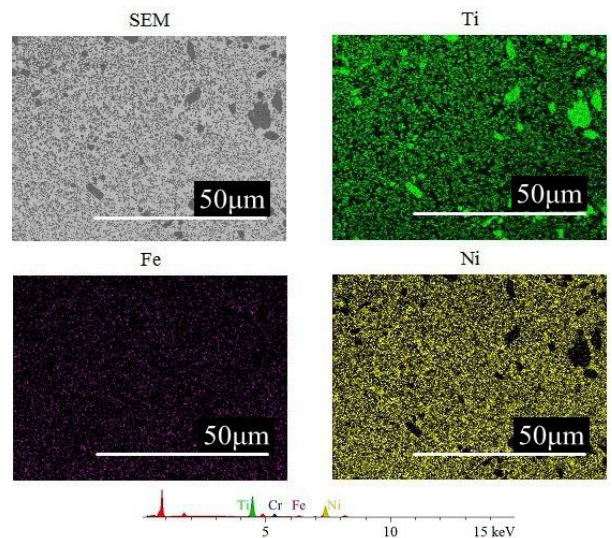
Figure 5. Element analysis on the cladding layer cross section (1.1 kW laser power).